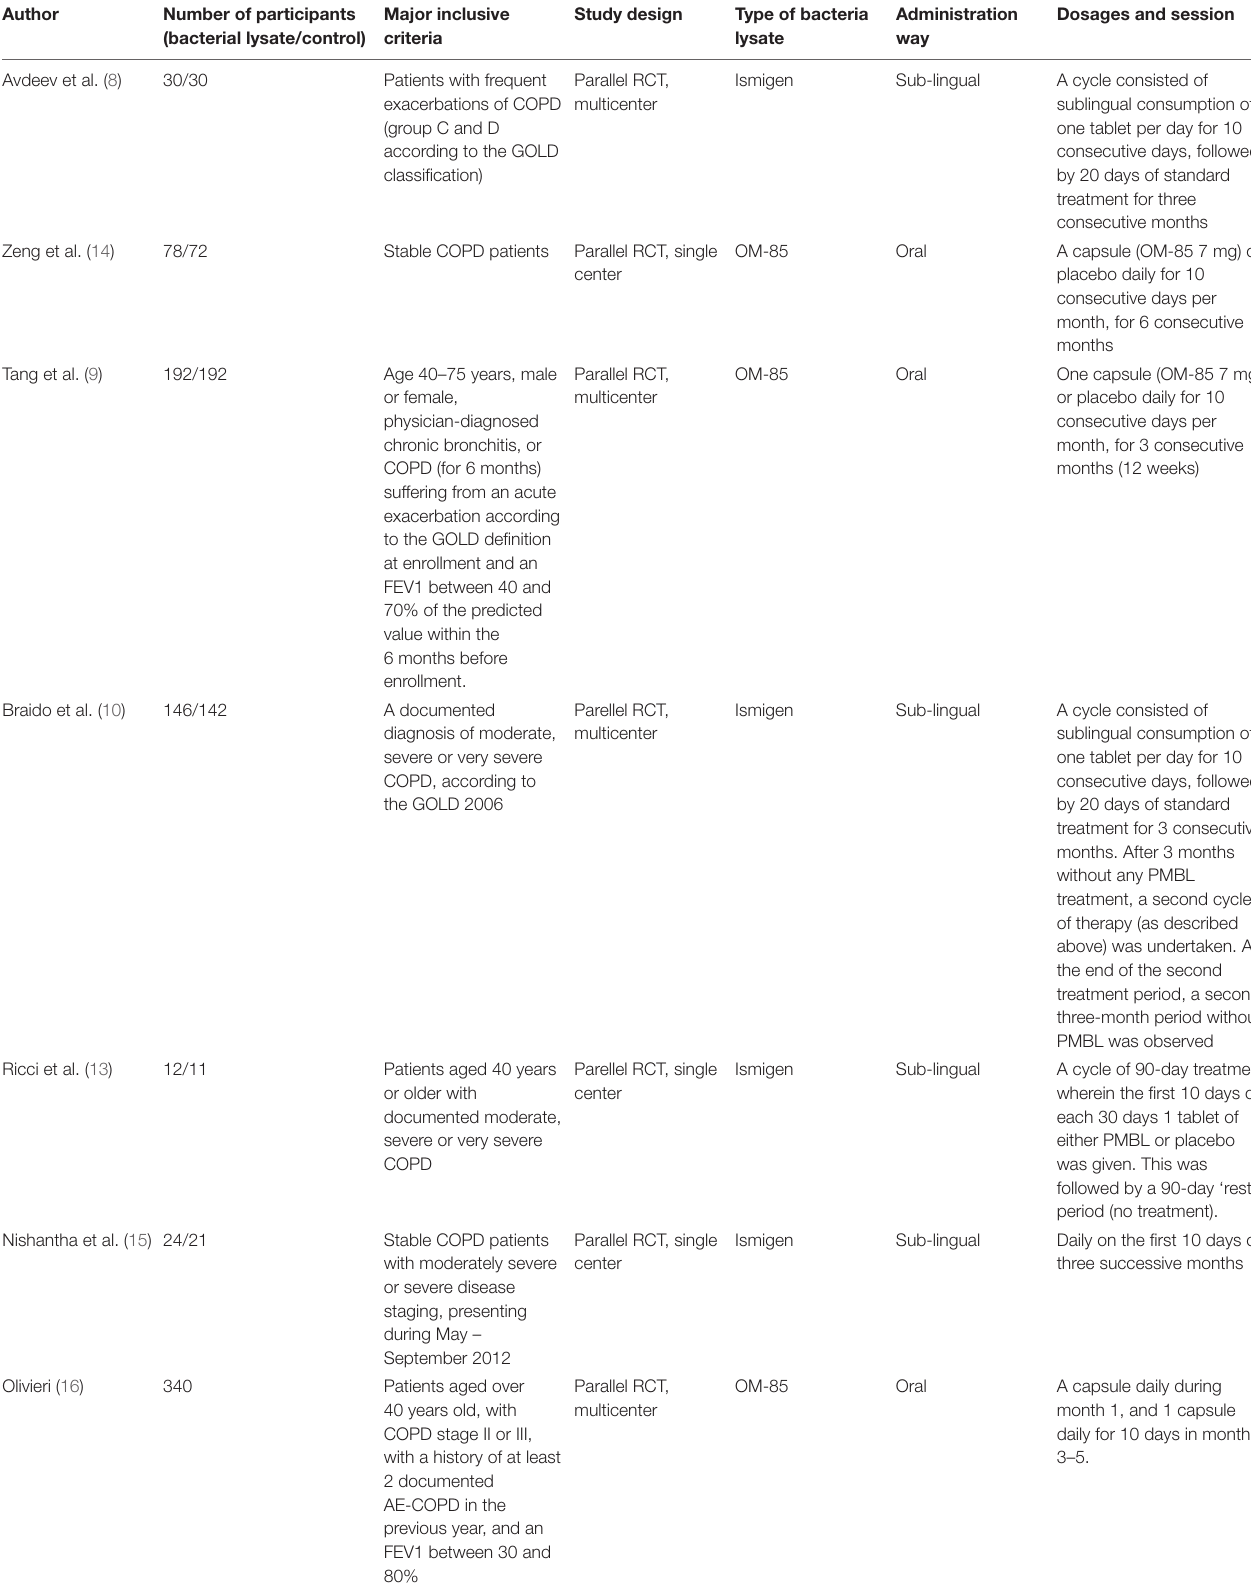
TABLE 1 | The characteristics of the included